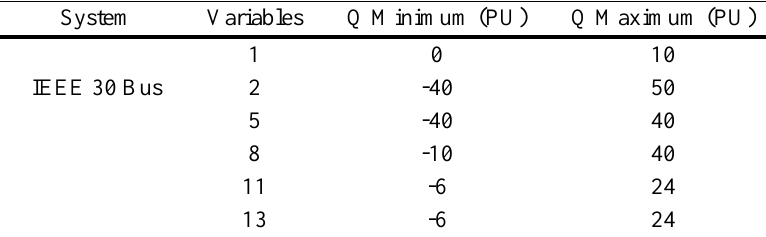
Table 5. Constrains of reactive power generators.